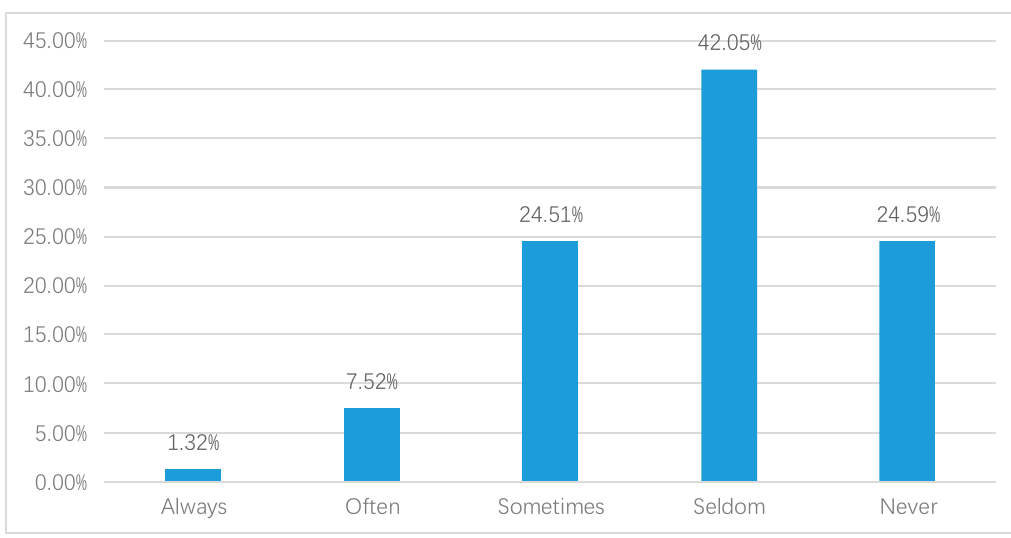
Figure 2. Self-reported health (weighted).